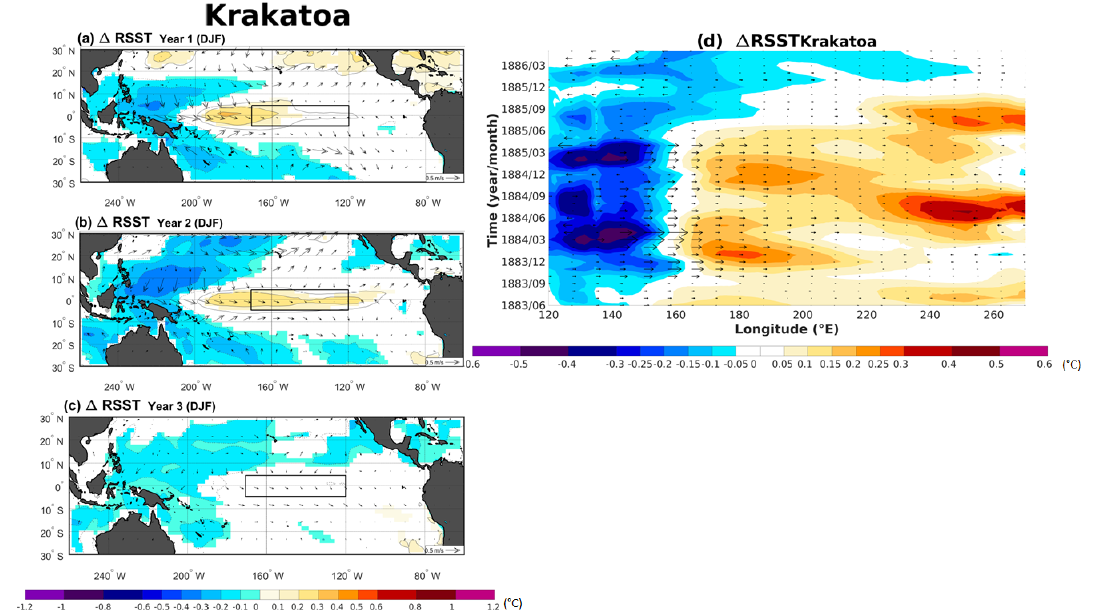
Figure A7. Ensemble mean of changes in relative sea surface temperature anomalies and 10m winds (arrows) between the climatology and the volcano case for the three winter seasons (DJF) after the Krakatau eruption. Only significant RSST changes are shown with an approximate 95% confidence level using Student’s t test. Contours show the RSST anomalies following the colour bar scale (solid lines for positive anomalies and dashed lines for negative anomalies). The boxes indicate the Niño 3.4 area.